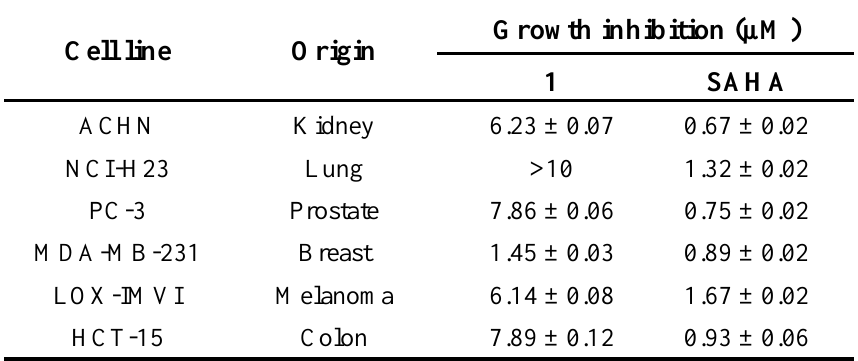
Table 2 . GI and origin type for cells treated with sulfur compound and 50